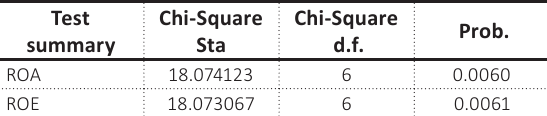
Table 4. Hausman test results